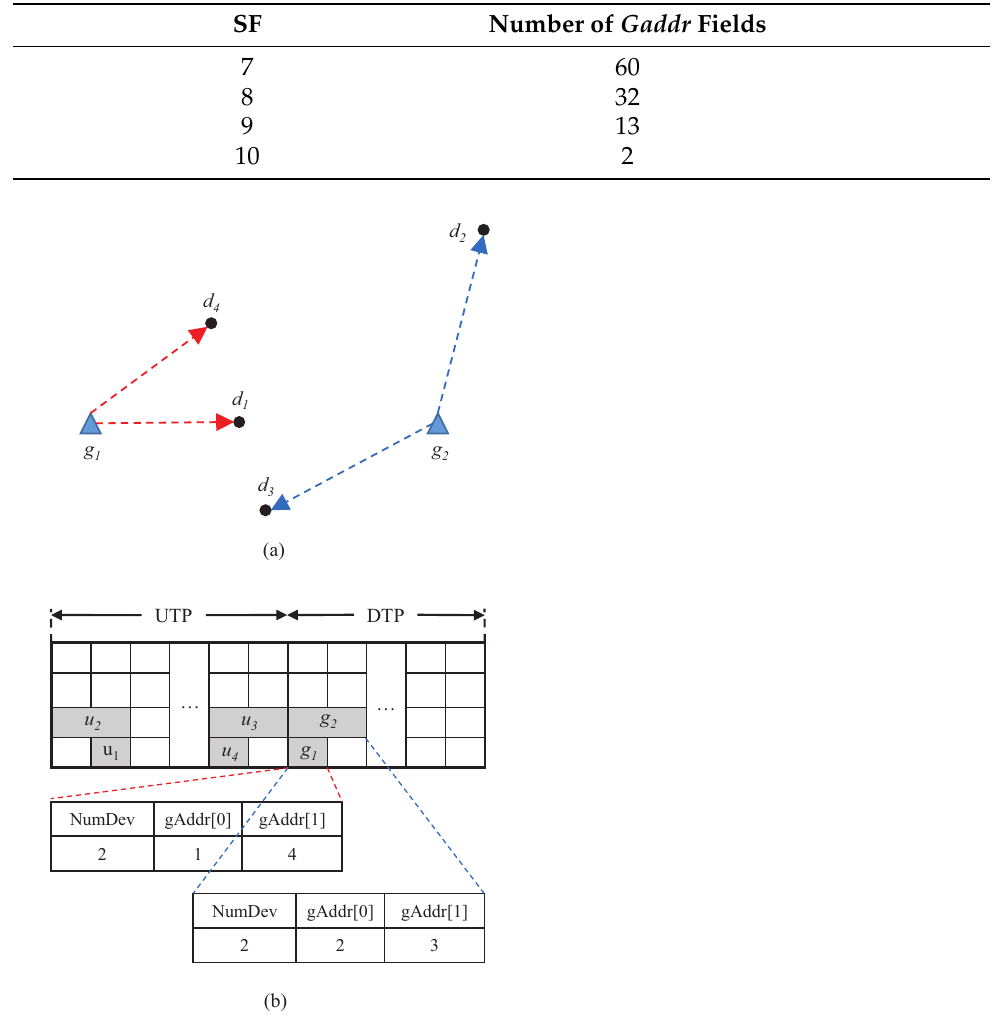
Table 2. The maximum number of gaddr fields in a GACK according to SF.